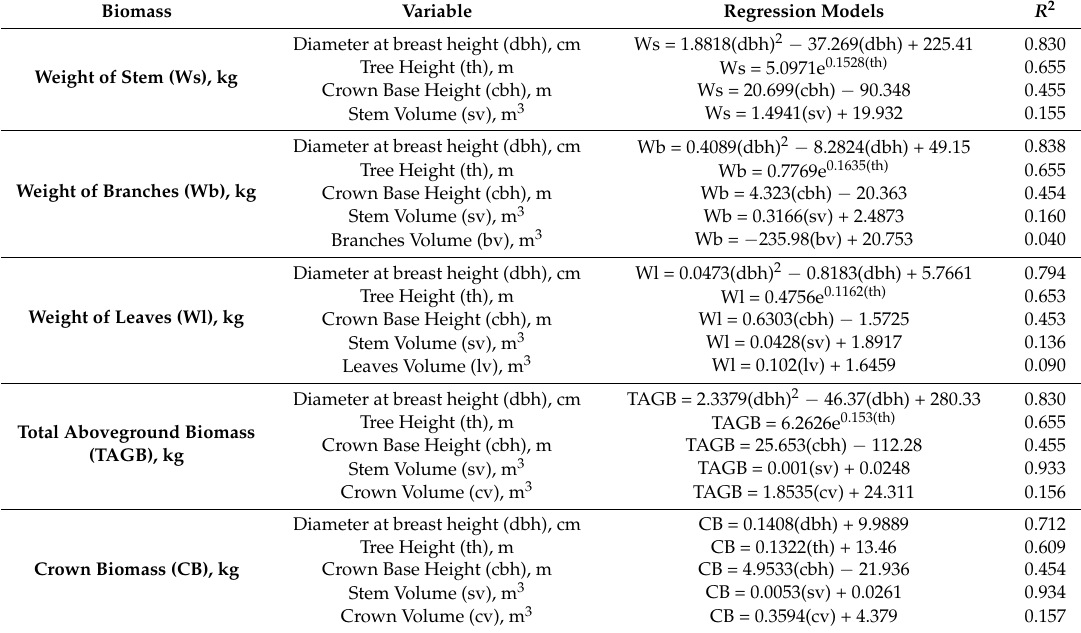
Table A5. Allometric equation generated for Medang with tree variables obtained from